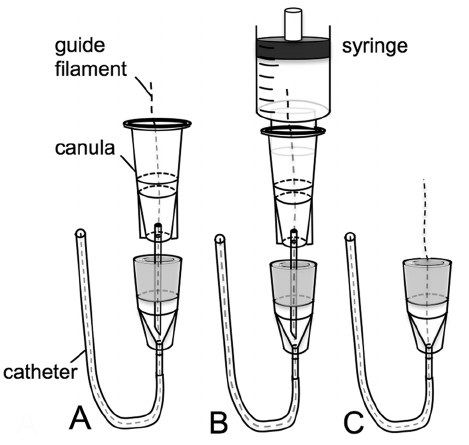
Figure 2. Schematic drawing of insertion of the guide filament into the VAMP. a) A 23 G cannula is inserted into the port and a 0.2– 0.25 mm nylon suture is advanced into the catheter tip. b) The port system is flushed with heparinized saline. Note that the proximal end of the nylon suture is advanced into the syringe. c) While flushing the VAMP, the cannula is slowly retracted to provide an air-free lumen of the port and the catheter.